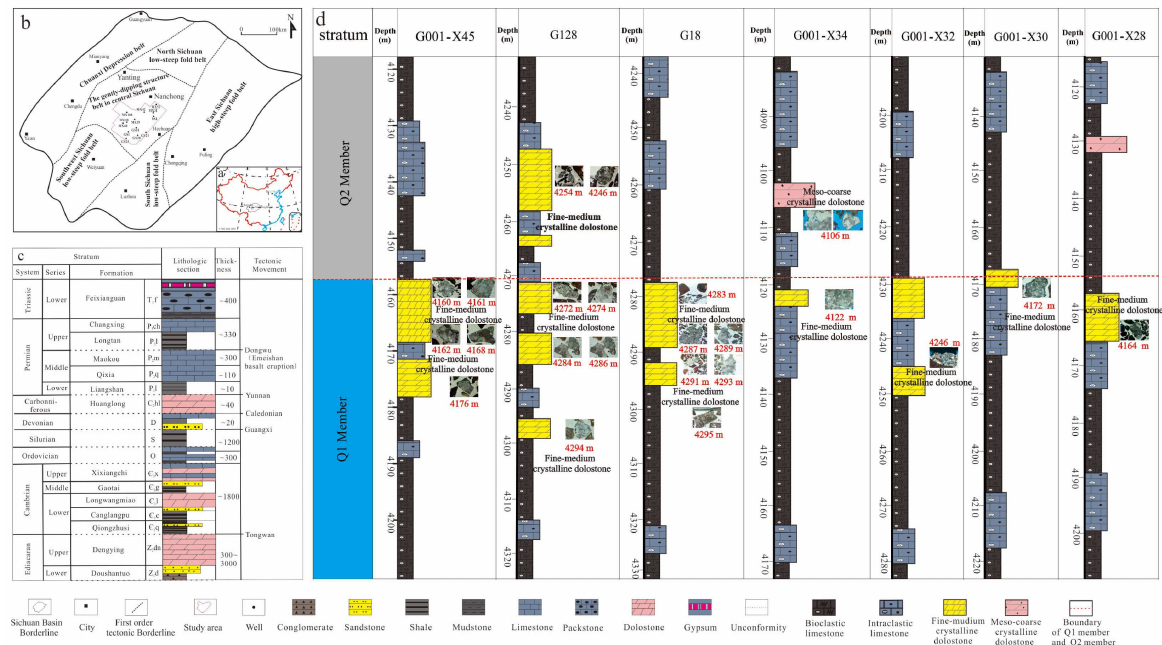
Figure 1. Geological setting of the study area. ( a ) The location of Sichuan Basin in southwestern China. ( b ) The study area is located in the red frame of ( b ). ( c ) Stratigraphic column and tectonic movements. ( d ) Vertical distribution of two types of